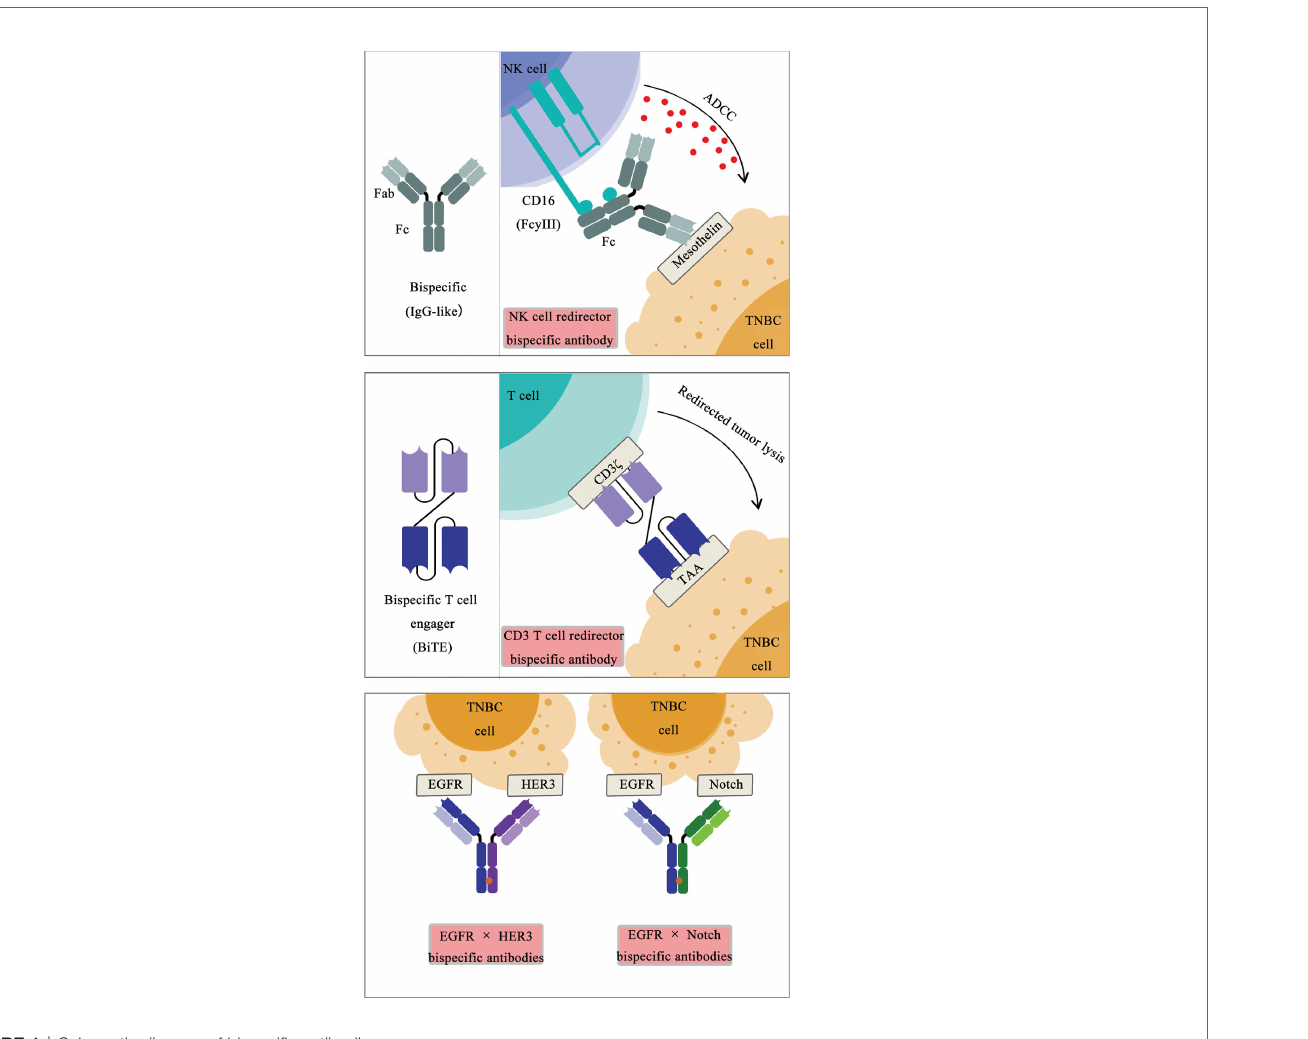
FIGURE 1 | Schematic diagram of bispeci fi c